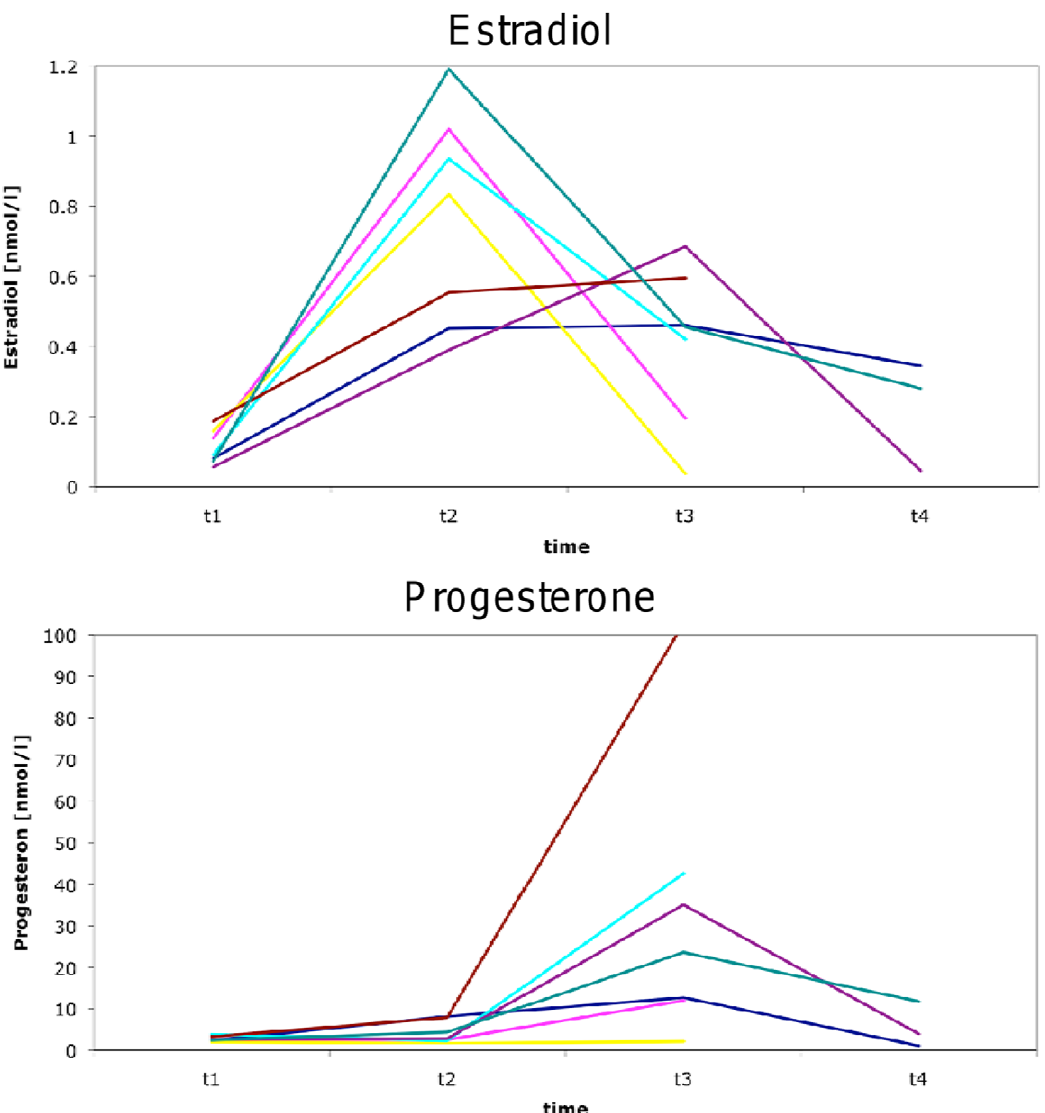
Figure 1. Quantitative hormone changes during the menstrual cycle for estradiol and progesterone of all 8 female subjects. For clarification, time points are connected by straight lines. Note: only half of the subjects were measured at t4; part of the lines overlie. All but one subjects showed hormone levels within physiological levels and indicating ovulatory cycles: This is an increase of estradiol levels at t2 and/or elevated progesterone levels after t2. One subject showed no increase in progesterone at t3, indicating missing ovulation, and was excluded from further studies, along with the matched male.